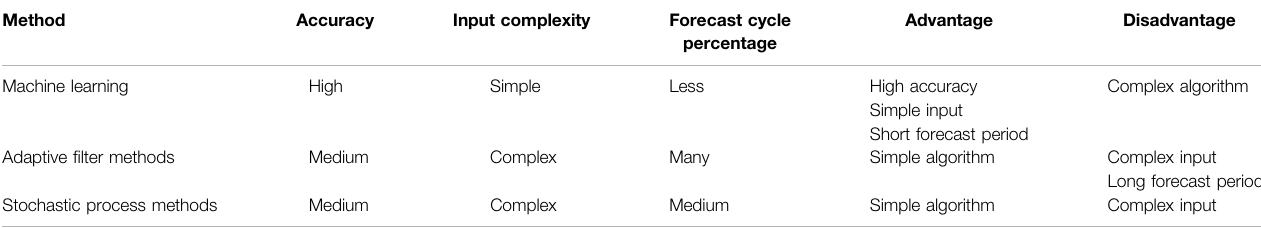
TABLE 4 | The comparison of stochastic process methods parameters.